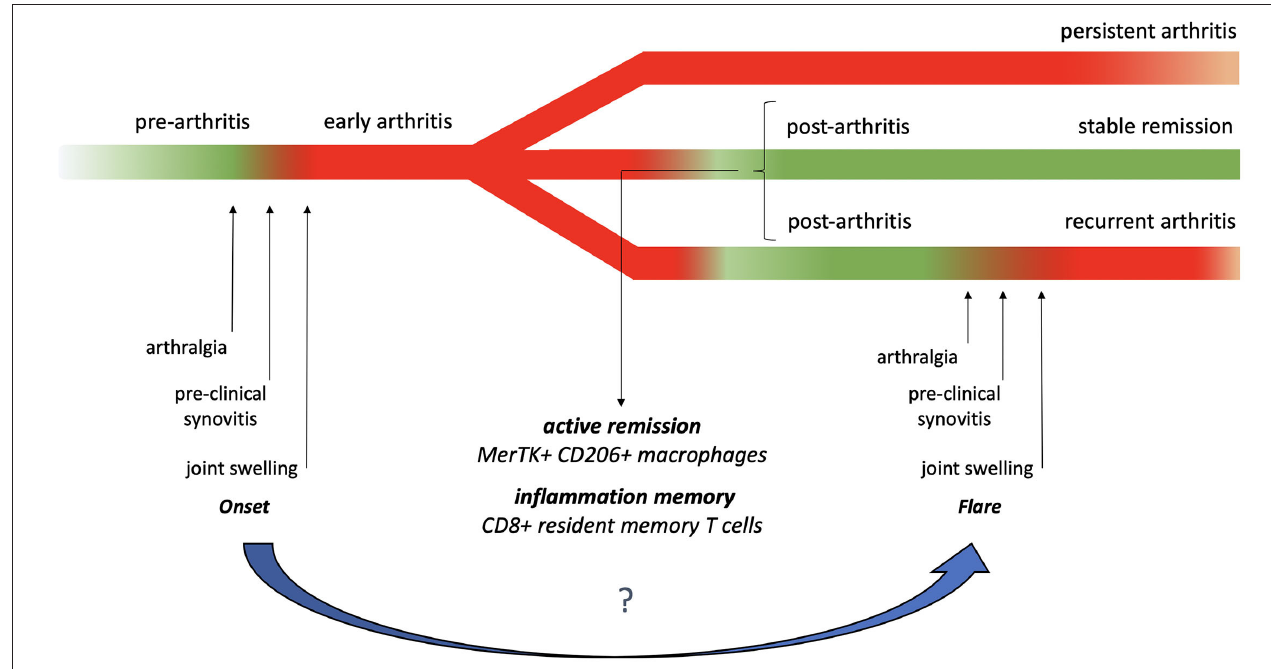
FIGURE 1 | Rheumatoid arthritis activity natural history. Rheumatoid arthritis’s natural history starts with pre-arthritis, where immunological and inflammatory changes occur in the absence of overt clinical manifestations. Following this phase, the process can evolve in overt joint swelling and in the typical clinical manifestations of RA. Patients may then experience a persistent state of active disease, reach and maintain remission, or experience a flare where a stepwise process resembling onset may occur. The mechanisms supporting the homeostasis in the post-arthritis remissions phase and the biologic dynamics of flare have not been fully clarified yet. The green and red sections of the diagram represent phases characterized by the absence or the presence of joint clinical manifestations,